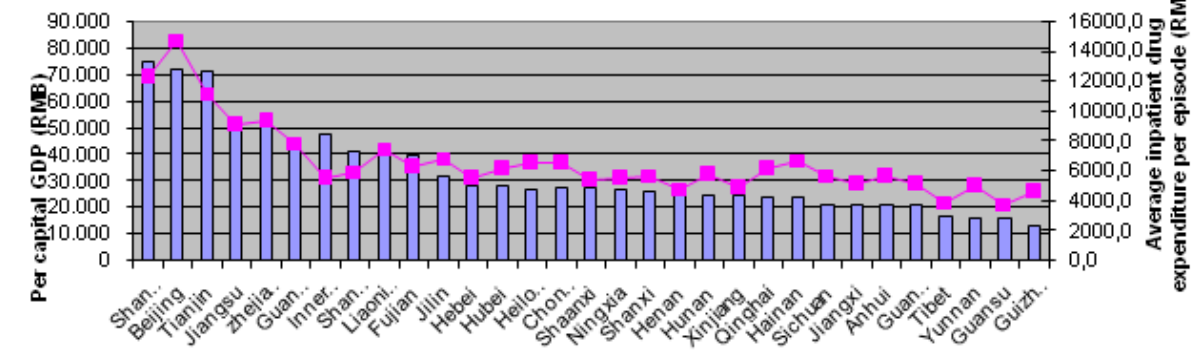
Figure 2 Per capita GDP and average medicines expenditure per inpatient visit, by region 2010. Source: ref.